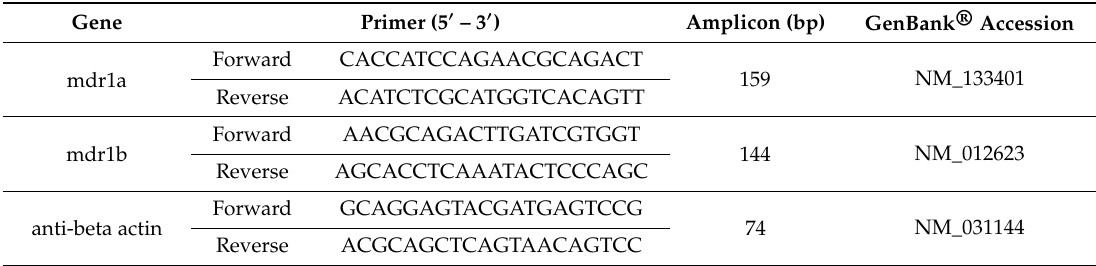
Table 1. Primers used for the analysis of P-gp gene expression by real-time qPCR.